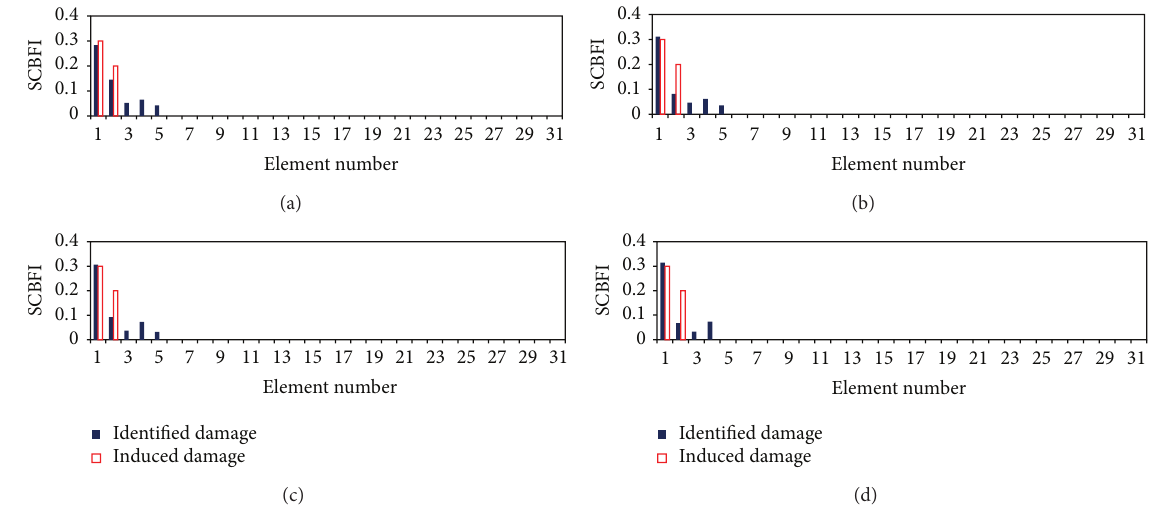
Figure 5: Damage identification for 31-bar truss for case 3 considering (a) 1 mode, (b) 2 modes, (c) 3 modes, and (d) 4 modes.